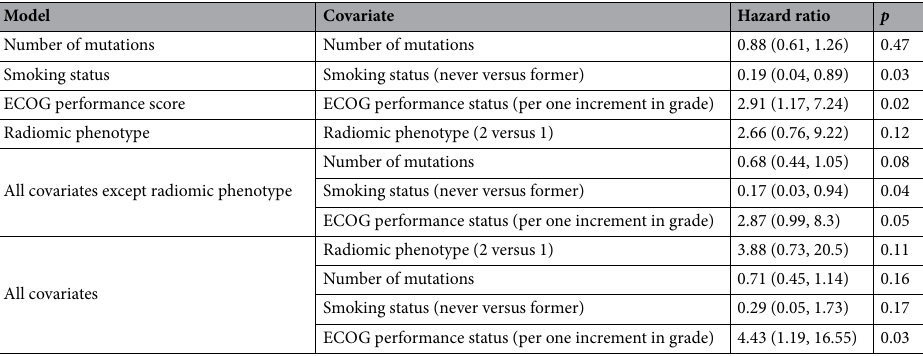
Table 3. Overall survival Cox regression hazard ratios.